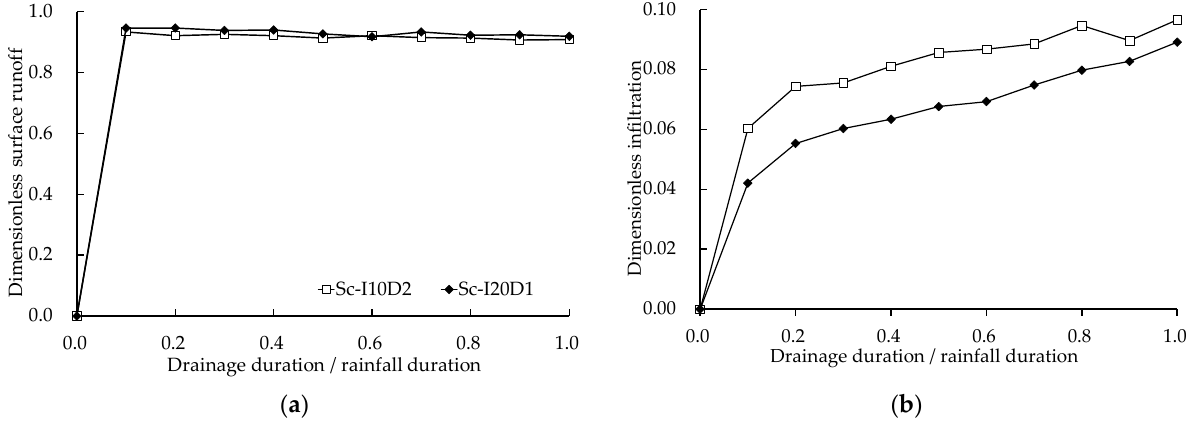
Figure 13. Scaled model simulation with rainfall depth 2.78 mm: ( a ) dimensionless surface runoff; ( b ) dimensionless infiltration.